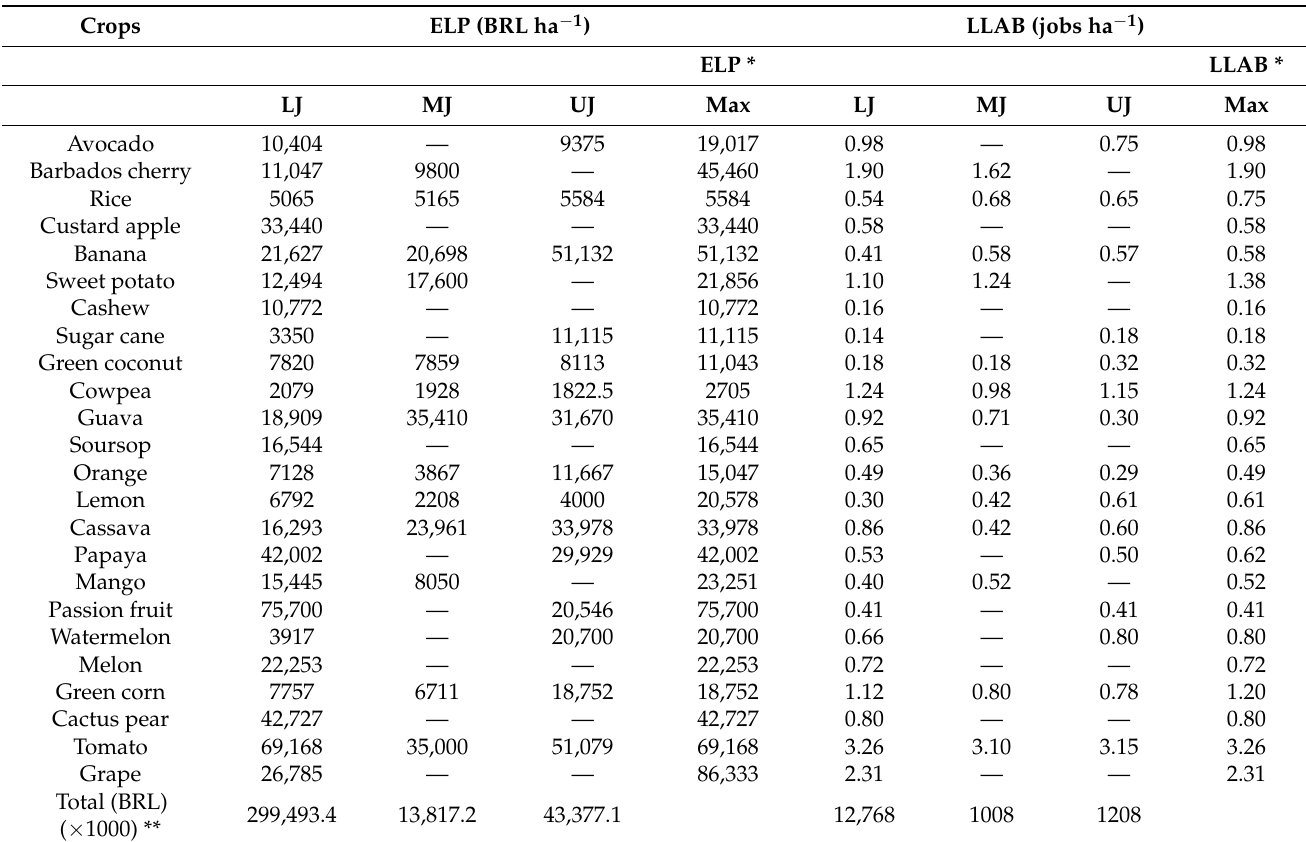
Table 3. Average net revenue (ELP) and maximum net revenue (ELPmax), average number of jobs (LLAB) and maximum number of jobs (LLABmax) per hectare in the Jaguaribe River basin. Amounts expressed in Reais (BRL), Brazilian currency.